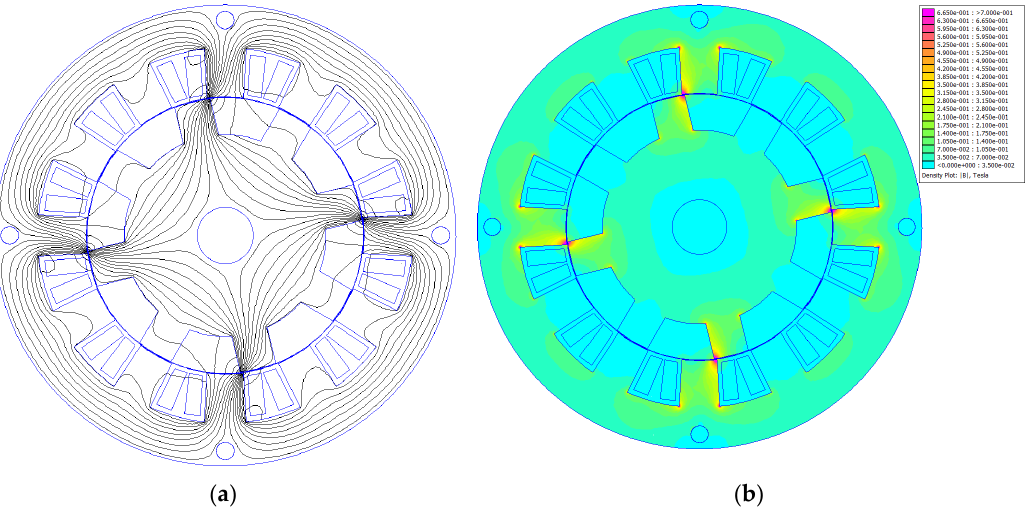
Figure 2. ( a ) Magnetic flux lines for the motor from Figure 1a, I = 1.25 A; ( b ) magnetic flux density for the motor from Figure 1a, I = 1.25 A, B max = 7 · 10 − 1 T